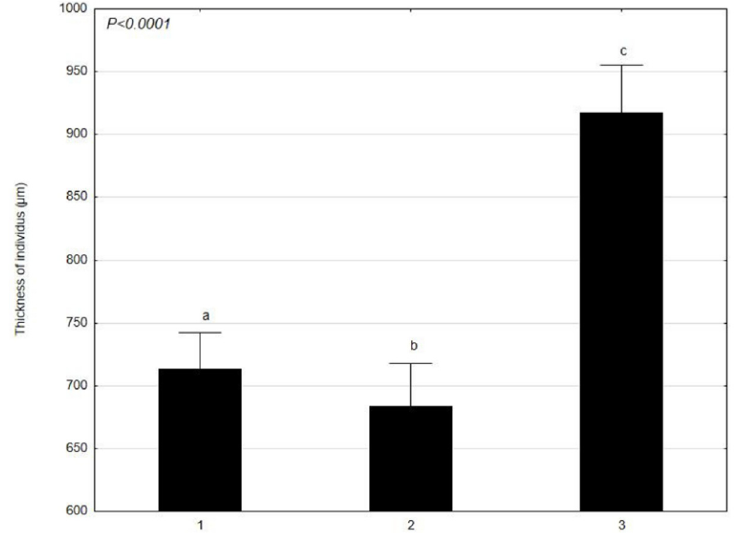
Figure 4. Mean values of L. minor feature (thickness of individuals) at different times (1–30 April 2021; 2–4 June 2021; 3–17 July 2021) presented using the Tukey multiple comparisons test. The bars indicate mean values. Error bars represent standard error. A, B, C determines the statistical significance between the analyzed features. A statistically significant result for p ≤ 0.05 was marked.